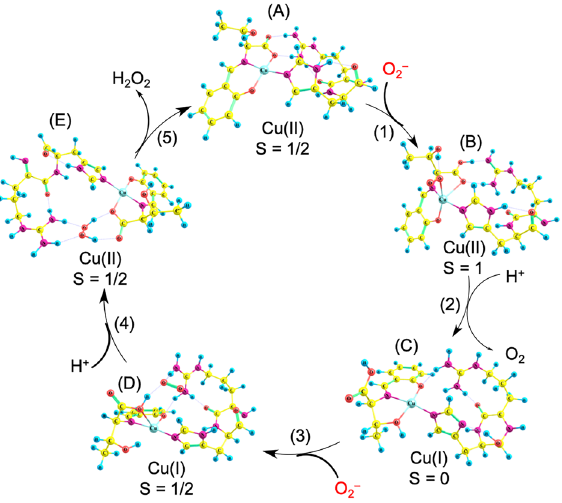
Figure 14. Theoretically proposed O 2 disproportionation mechanism. A simplified model compound coordinated by an additional ligand with an Arg–His framework (CuST–Arg–His) was